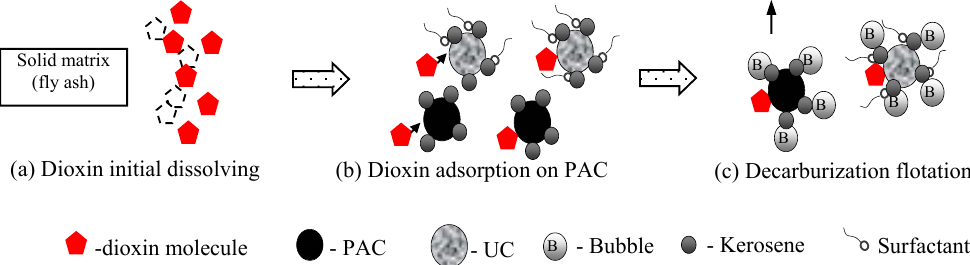
Figure 12. Conceptual diagram of dioxin removal regarding interactions between polychlorinated dibenzo-p-dioxins (PCDD)/F molecules, powder-activated carbon (PAC), unburned carbon (UC), bubbles and kerosene during flotation.